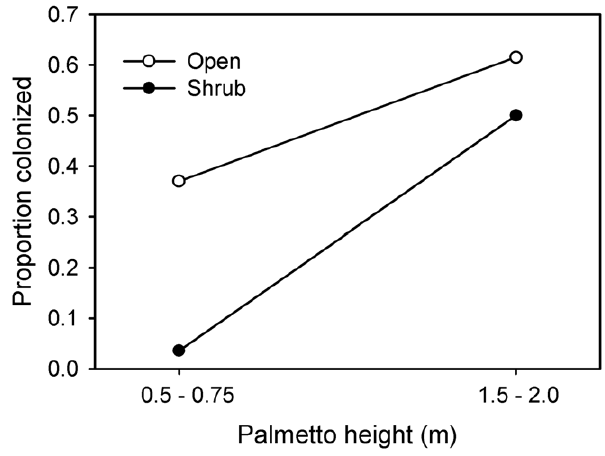
Figure 3. The effect of palmetto height and understory cover (open or shrub) on the proportion of potted palmettos bearing new PLS colonies.